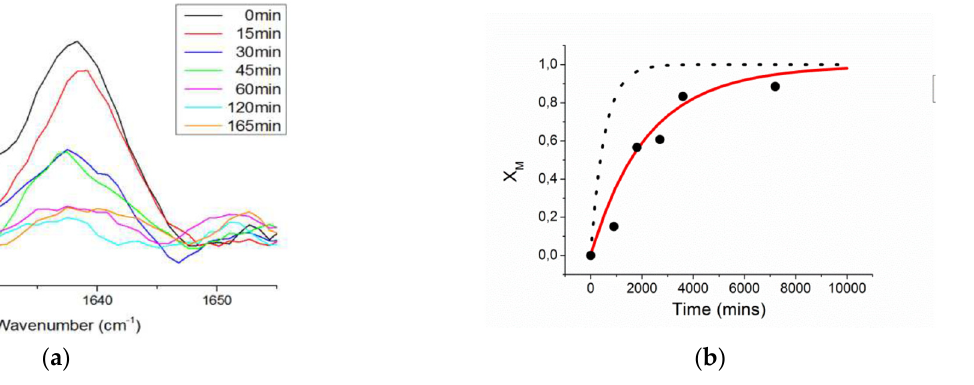
Figure 6. ( a ). The Raman spectra of in situ polymerized PFA in AAO templates as a function of time. ( b ) Graph of conversion versus time for polymerization of PFA in AAO template. Symbols represent experimental points while the dotted and solid lines represent the model prediction for bulk and nanoconfined polymerization, respectively [125]. Copyright 2015. Reproduced with permission from the publisher: RSC.